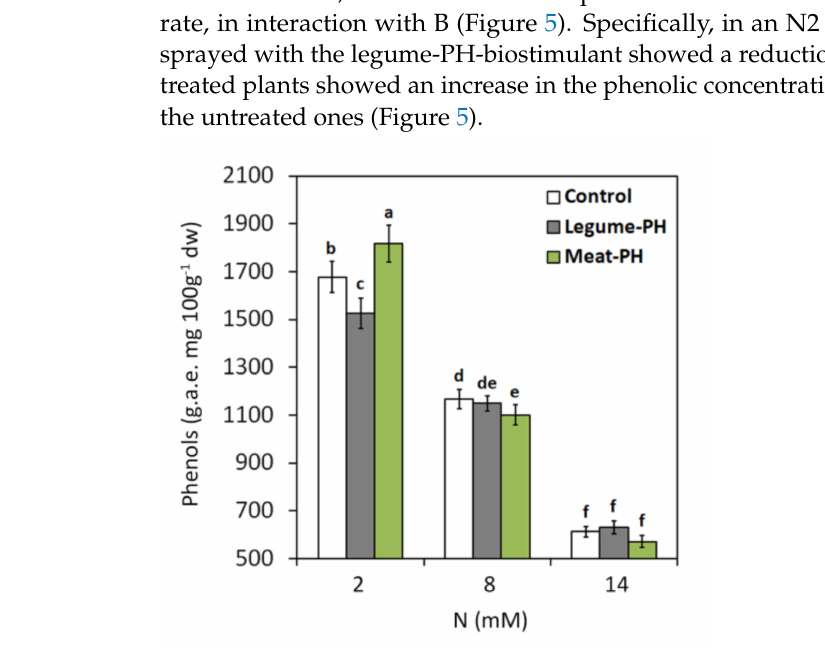
Figure 5. Effect of nitrogen doses and foliar application of biostimulants on phenols of spinach leaves. Vertical bars (standard error) (n = 9) with different letters are significantly different according to the LSD test ( p =